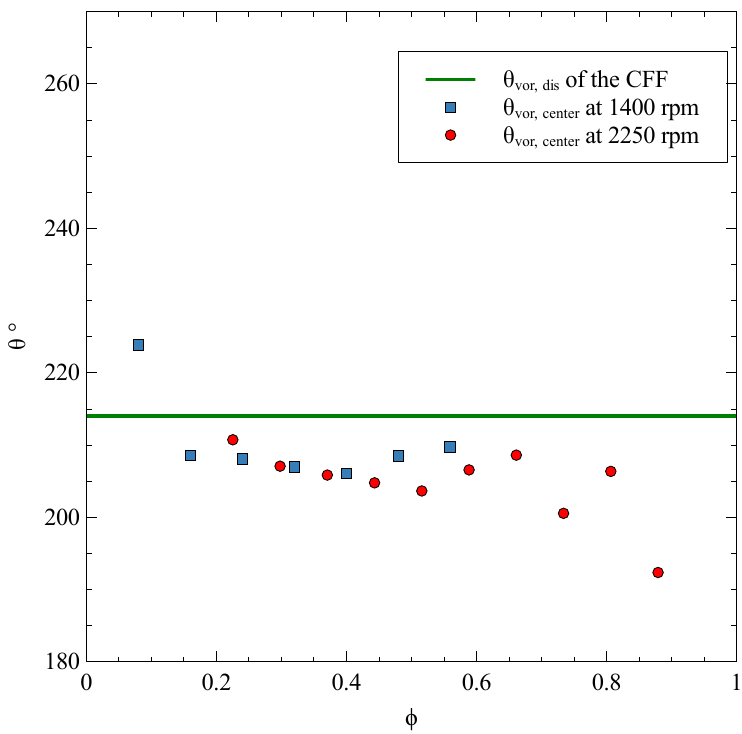
Figure 24. Comparison of the vortex angular coordinate with θ vor , dis of the Eck/Laing